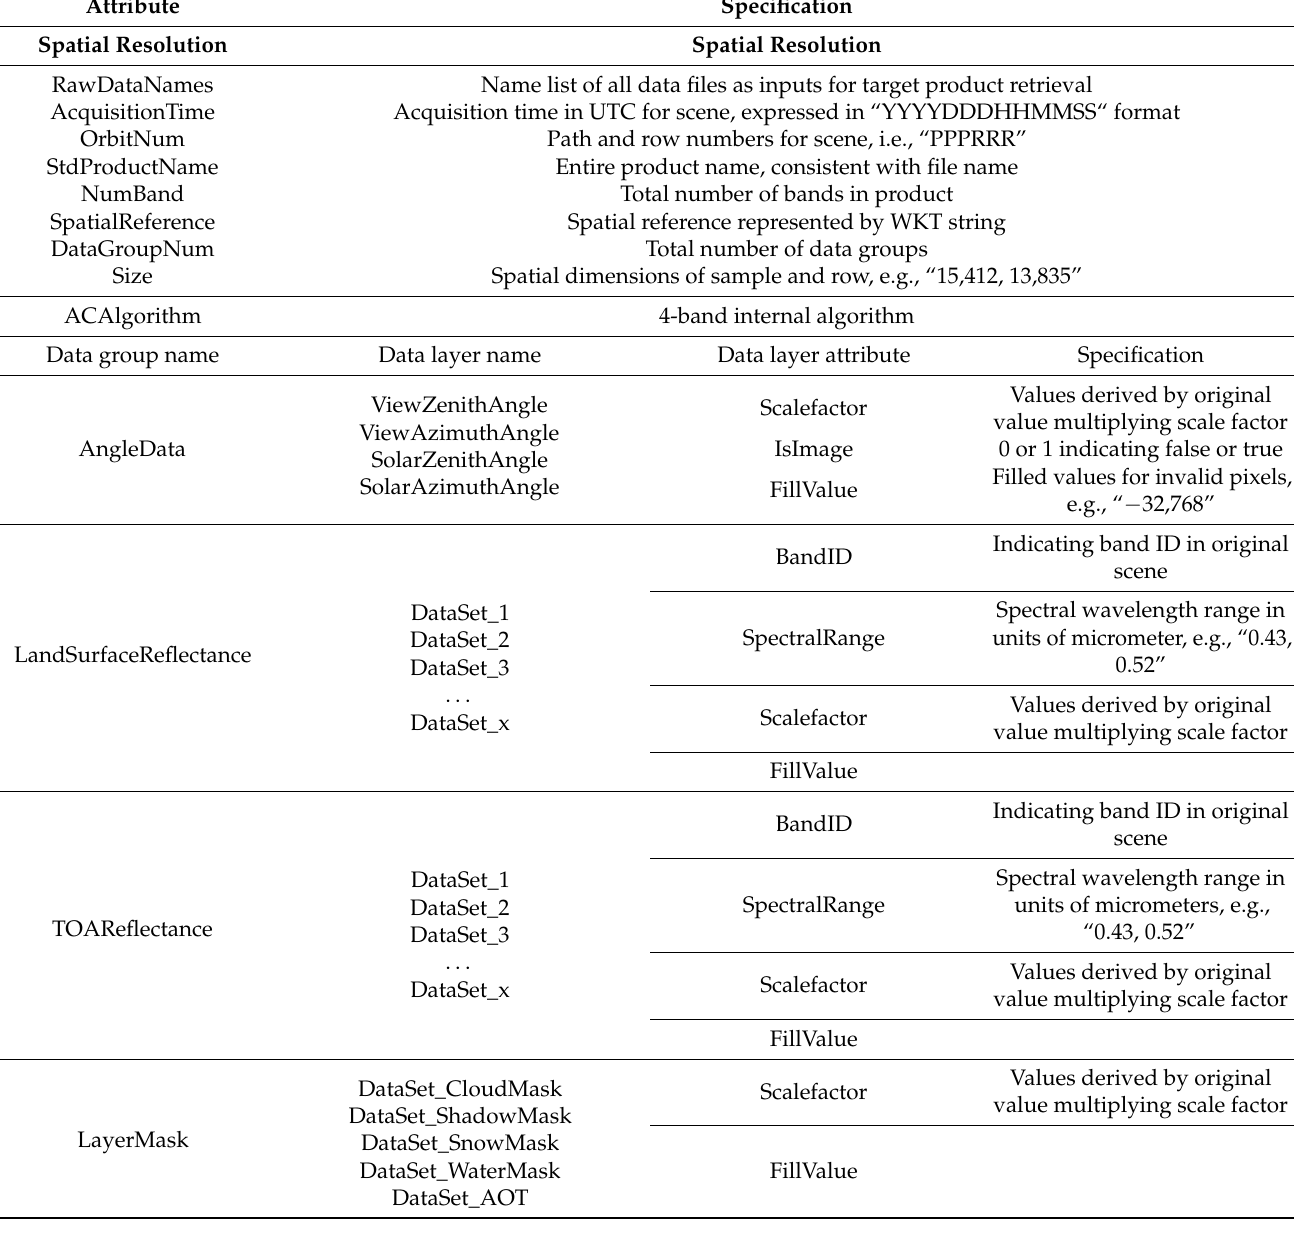
Table 5. Specifications for output product in HDF5